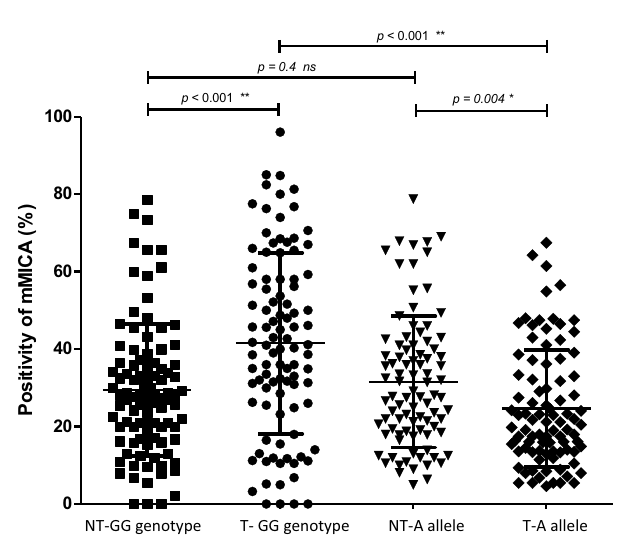
Table 1. Characteristics of the 193 HCC patients. Note: BMI: body mass index.AST: aspartate aminotransferase. ALT: alanine aminotransferase. HBV: hepatitis B virus. HCV: hepatitis C virus. B + C: hepatitis B and hepatitis C coinfection. NBNC: non-hepatitis B and non-hepatitis C. HCC: hepatocellular carcinoma. BCLC: Barcelona Clinic Liver Cancer. MICA: MHC class I chain-related A. * 6 patients had indeterminate single nucleotide polymorphism. † Data available in 119 patients.